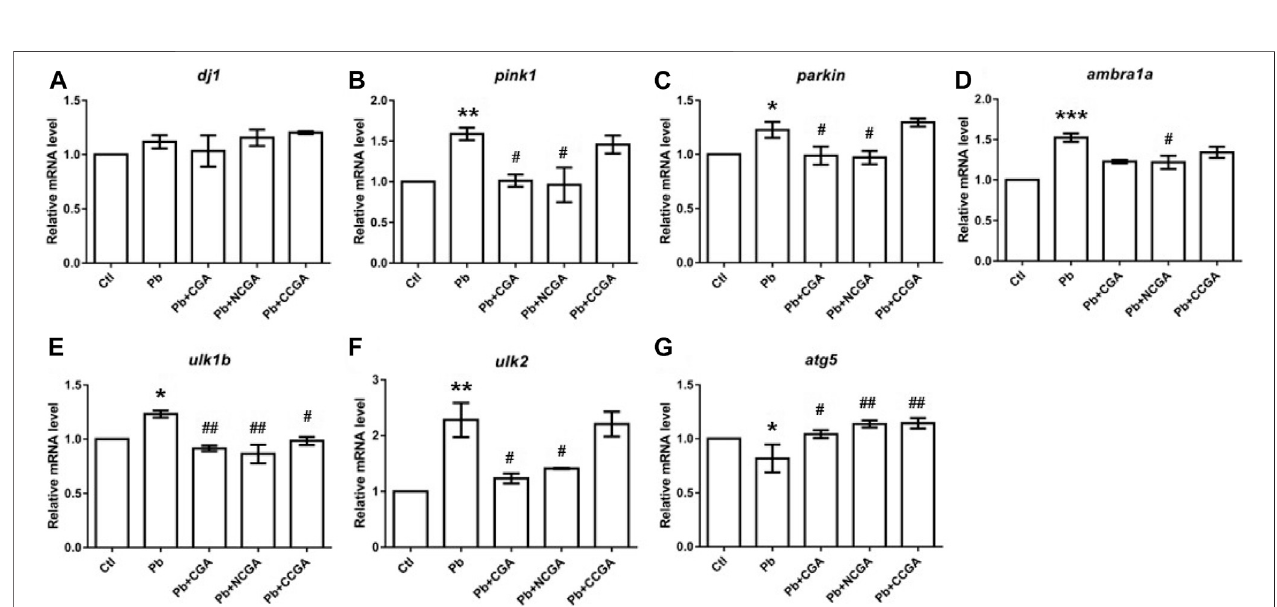
FIGURE 9 | Transcription of genes related to parkinsonian and autophagy. The graph plot is represented as fold changes in the mRNA expression of dj1 (A) , pink1 (B) ,parkin (C) ,ambra1a (D) ,ulk1b (E) ,ulk2 (F) ,andatg5 (G) .Datawererepresentedasmean ± SEM, n (cid:1) 3,andstatisticallyanalyzedbyone-wayANOVAfollowed by Dunnett ’ s multiple comparison test. * p < 0.05, ** p < 0.01, *** p < 0.001 vs. control and # p < 0.05, ## p < 0.01, ### p < 0.001 vs.